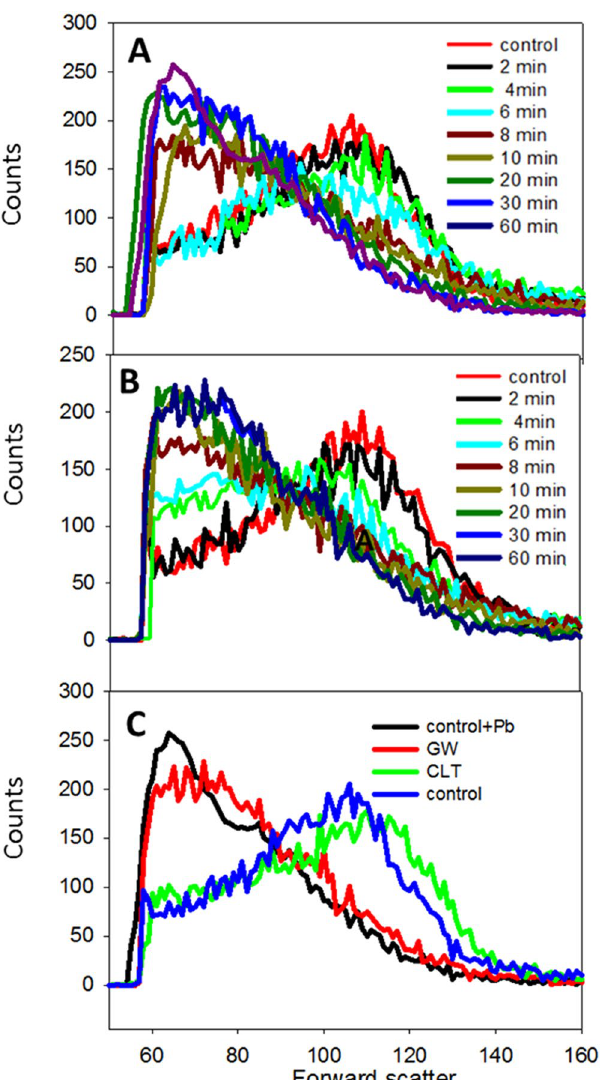
Figure 4. Monitorization of Pb(II) effect on RBC by FACS and the effect of inhibitors. RBC + Pb 2 + ( A ), GW4869-treated RBC + Pb 2 + ( B ) and comparison of control RBC (blue), + Pb 2 + (black), GW4869- treated + Pb 2 + (red) and CLT-treated + Pb 2 + (green) after 60 min Pb 2 + incubation ( C